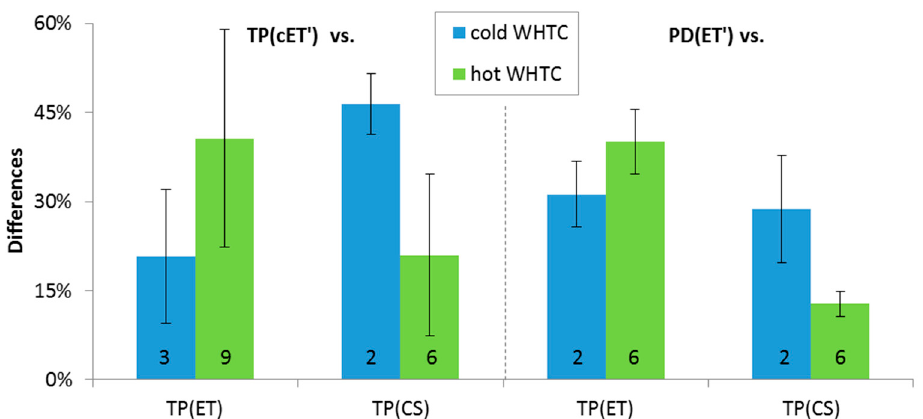
Figure 9. Comparison of > 23 nm emissions measured with the PMP system with evaporation tube